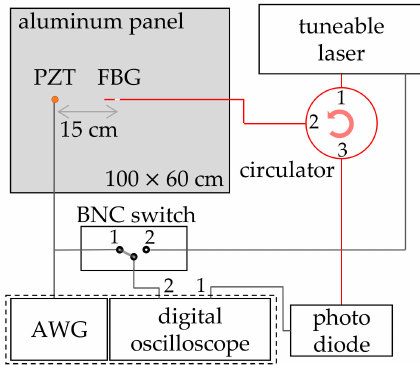
Figure 2. Experimental setup. Black lines represent electric BNC connections, red lines optical fiber connections.